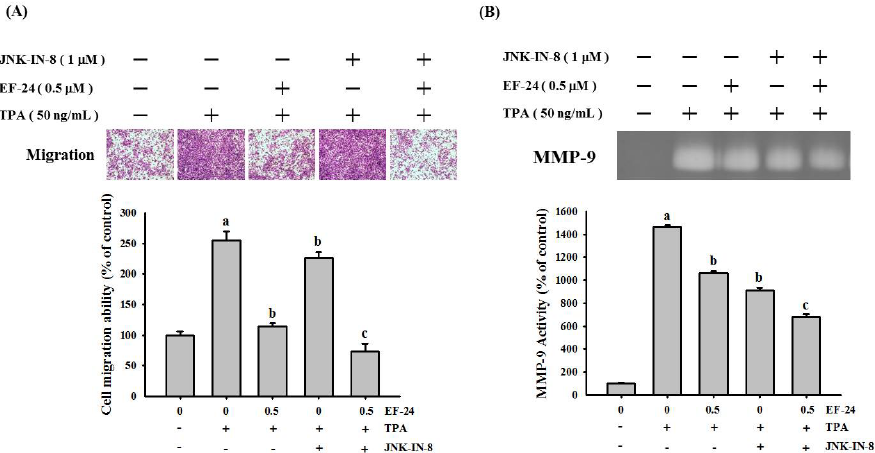
Figure 6. Synergistic effect of EF-24 and JNK-IN-8 on suppressing cell invasion and MMP-9 activity in NPC. HONE-1 cells were pretreated with EF-24, JNK-IN-8, or both for 1 h and then incubated with TPA for 23 h. Cell invasion responses were assessed by Boyden chamber assays ( A ), and MMP-9 activities were measured by gelatin zymography ( B ). a p < 0.05, compared with the untreated control; b p < 0.05, compared with TPA-treated cells; c p < 0.05, compared with the TPA + EF-24 treated cells.